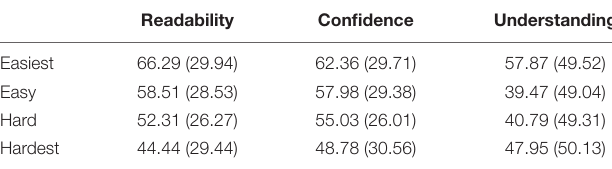
TABLE 2 | The mean readability, reader confidence, and reader understanding observed in the experiment at each level of difficulty as generated from the responses of